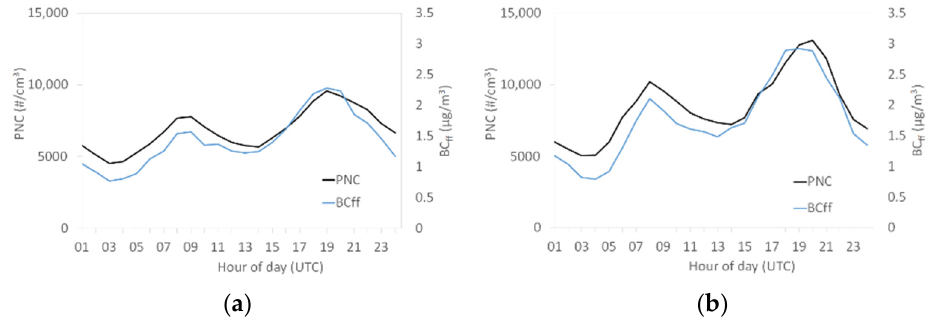
Figure A3. Average daily profiles of fossil-fuel combustion contribution to black carbon (BCff) ( a ) for background site and ( b ) for roadside site over the measurement period